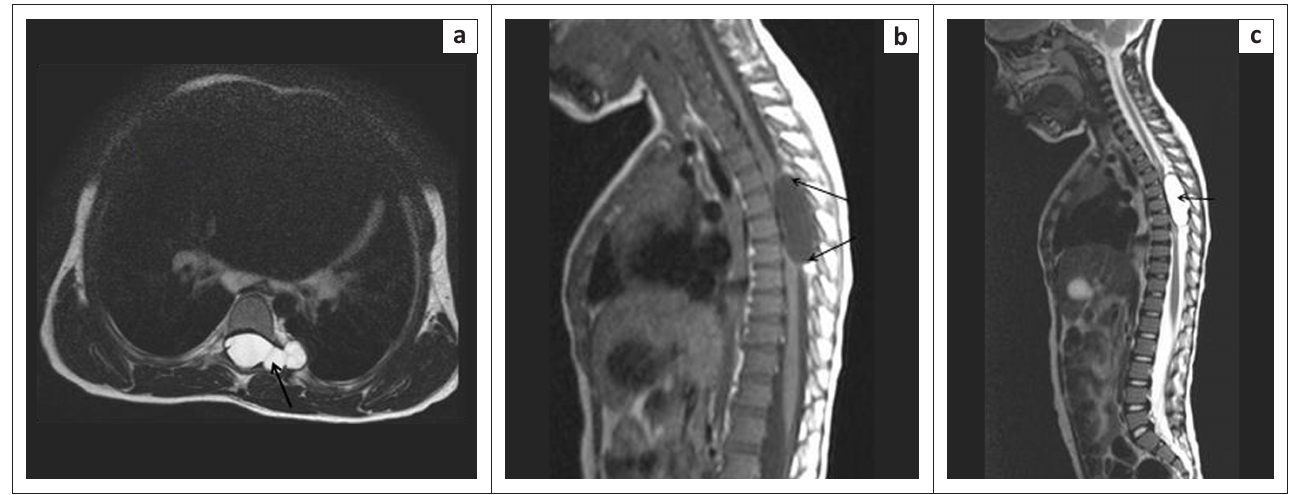
MRI, magnetic resonance imaging. FIGURE 3: (a) Axial MRI showing T2 weighted image cyst (arrow) extending through exit foramen of T6–7; (b) Sagittal T1 weighted MRI image demonstrates the cyst to have dome-shaped ends (arrow) filling up the entire spinal canal with compression of cord from T4 to T7; (c) Sagital T2 weighted MRI image demonstrating cyst to be of high signal intensity with no solid components (arrow).